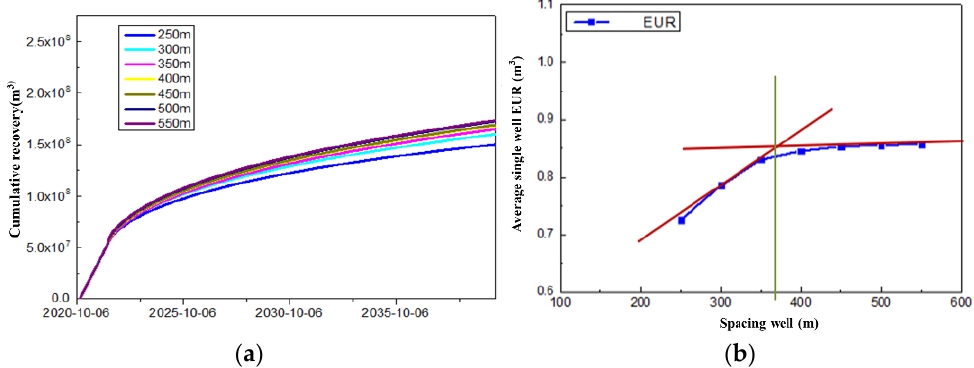
Figure 12. The cumulative recovery and average single well EUR under different well spacings: ( a ) the cumulative recovery; ( b ) the average single well EUR.